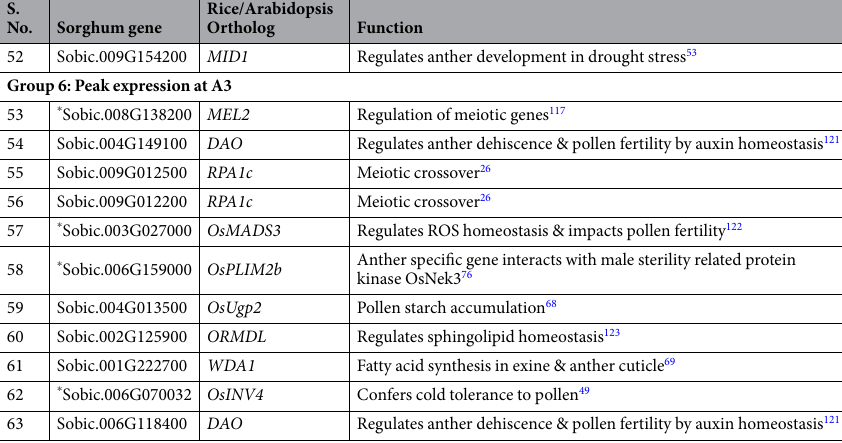
Table 1. List of shortlisted candidates for in-depth characterization. * Genes marked with asterisk exhibit anther-preferential